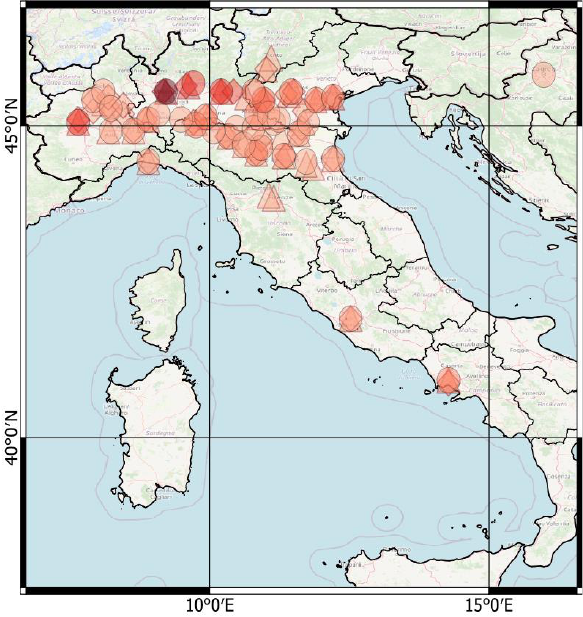
Figure 11. Hotspots with average values above 60 µmol/m 2 . Shapes represent the year: triangles are 2019, rhomboids 2020 and circles